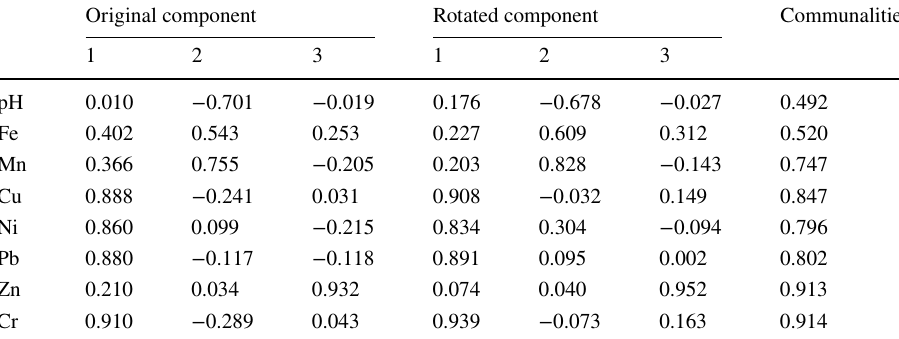
Extraction Method: Principal component analysis. Three